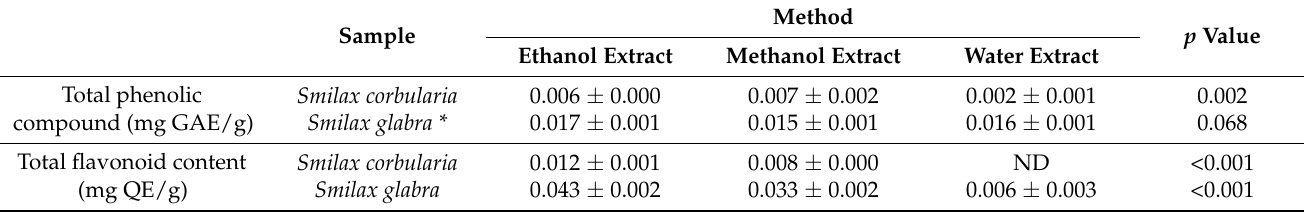
Table 5. Total phenolic compound and total flavonoid contents of Smilax glabra and Smilax corbularia